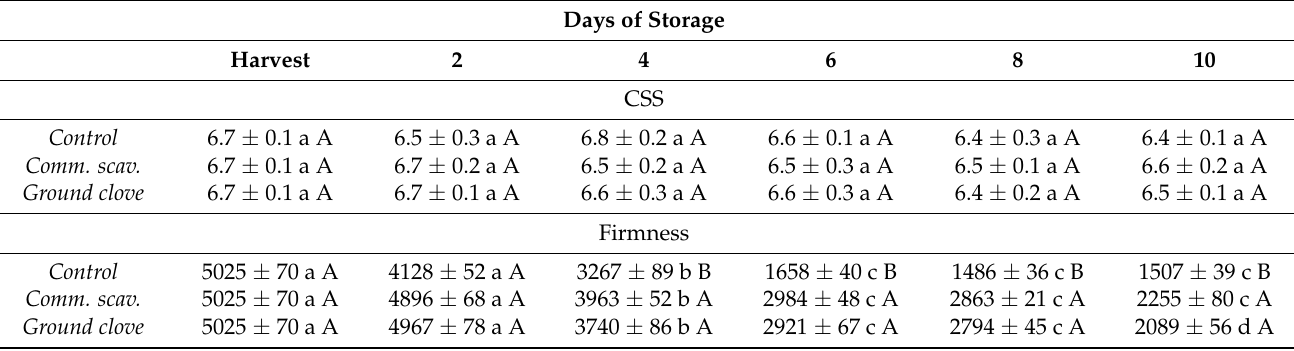
Means followed by SE ( n = 15). Different lowercase letters (a, b, c, d) indicate significant differences within treatments between days of storage according to the LSD test at p < 0.05. Different capital letters (A, B) indicate significant differences within each day of storage between treatments according to the LSD test at p <